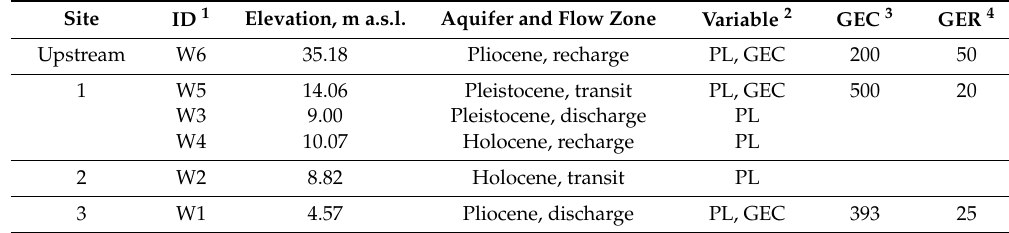
Table 2. Description of MASW and ERT surveys.